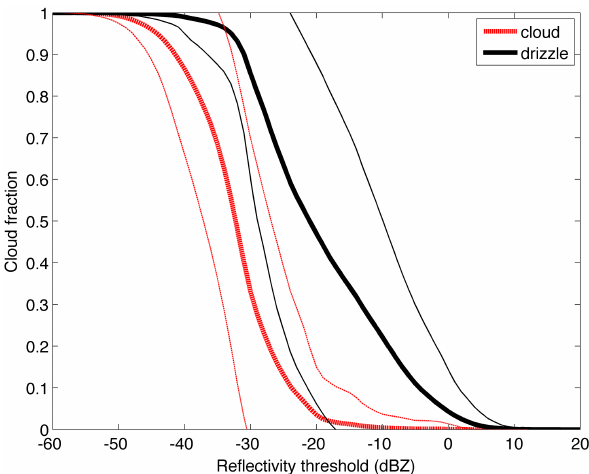
Fig. 2. The radar-detected cloud fraction (mean (thick lines) and standard deviation (thin lines)) for boundary layer clouds at the Azores during the CAP-MBL deployment shown as a function of the radar sensitivity (threshold). Two categories of boundary layer clouds are shown: drizzle-free clouds (red lines) and drizzling clouds (black